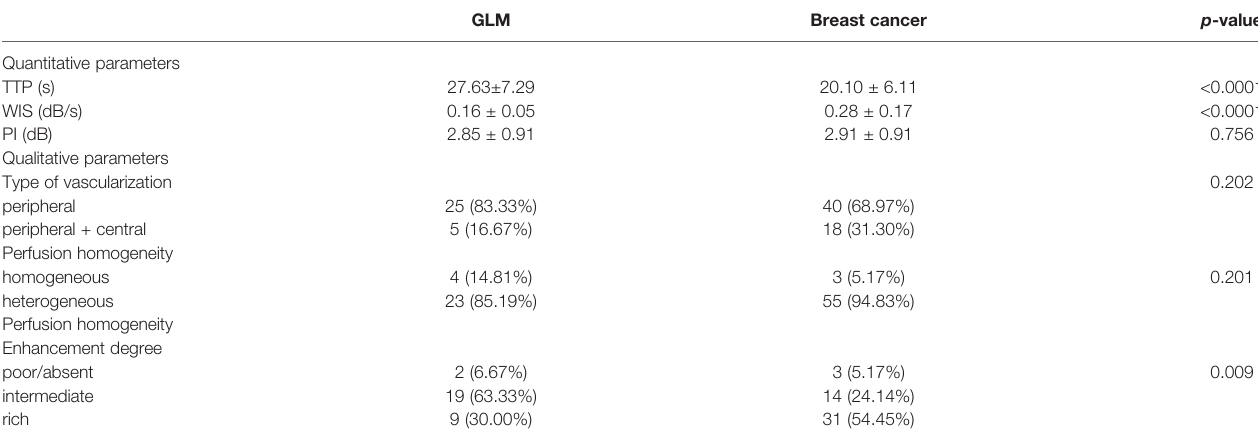
TABLE 2 | Quantitative and qualitative parameters of breast CEUS according to the